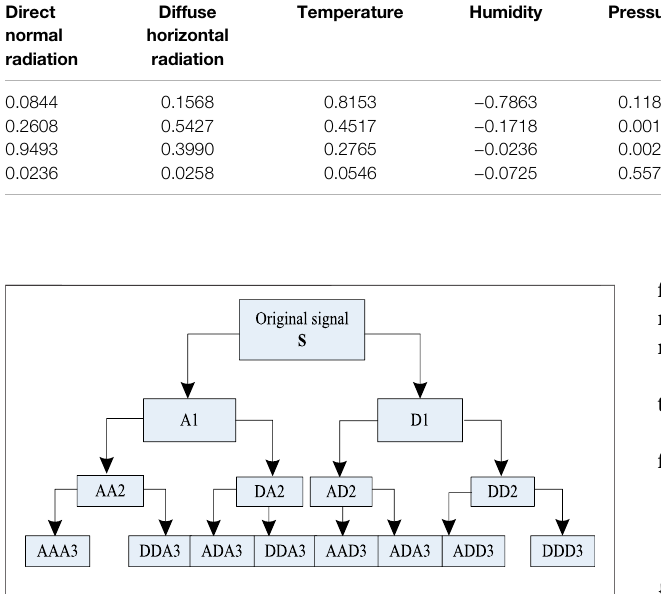
FIGURE 1 | WP decomposition